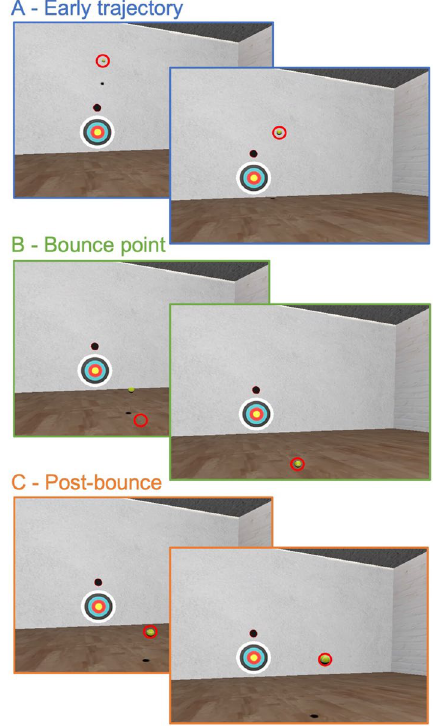
Figure 1. Typical interceptive eye movements in this task. Figure shows screenshots from the interception task with theoretical point of gaze (red circle) superimposed. The figure shows successive points in the ball trajectory form the early release ( A ), just before and during the bounce point ( B ), and during the post-bounce period, just before the ball is hit. Gaze typically tracks the early portion of the trajectory, then saccades ahead to the bounce point, waits for the ball to catch-up, then tracks the ball during the post-bounce